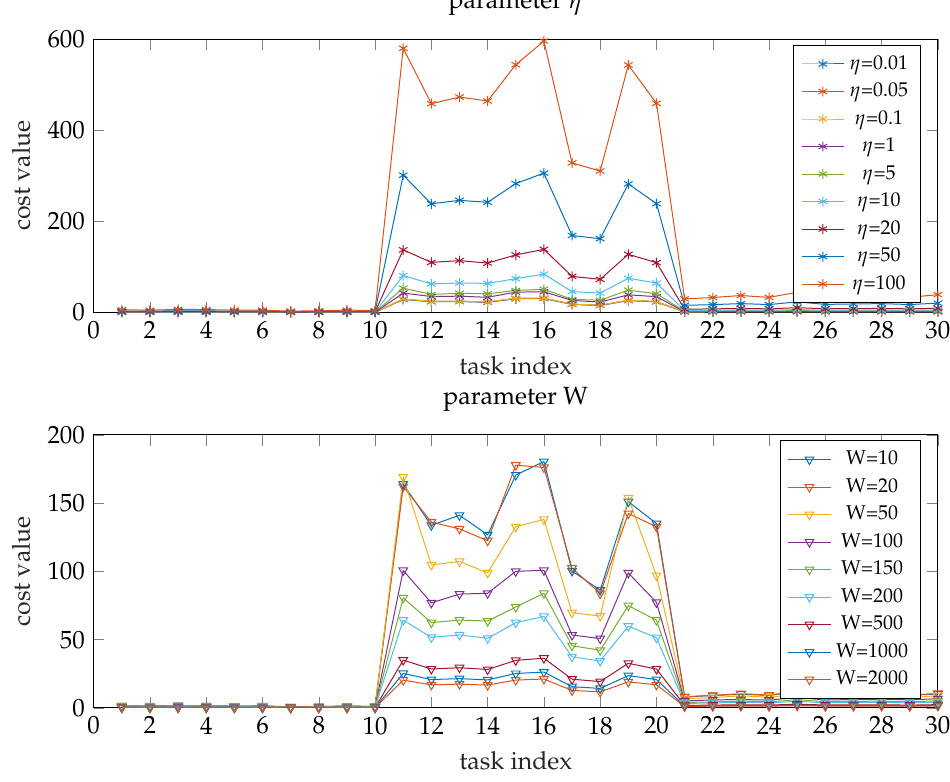
Figure 6. The cost values under different